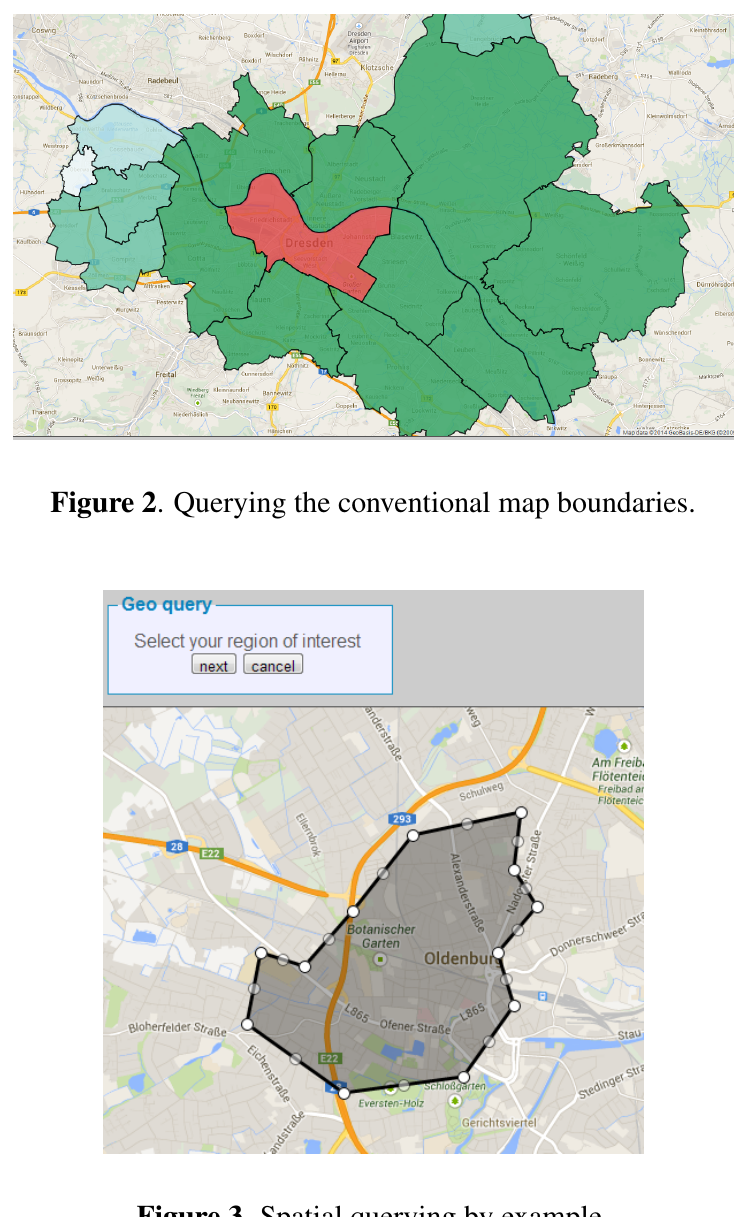
Figure 3 . Spatial querying by